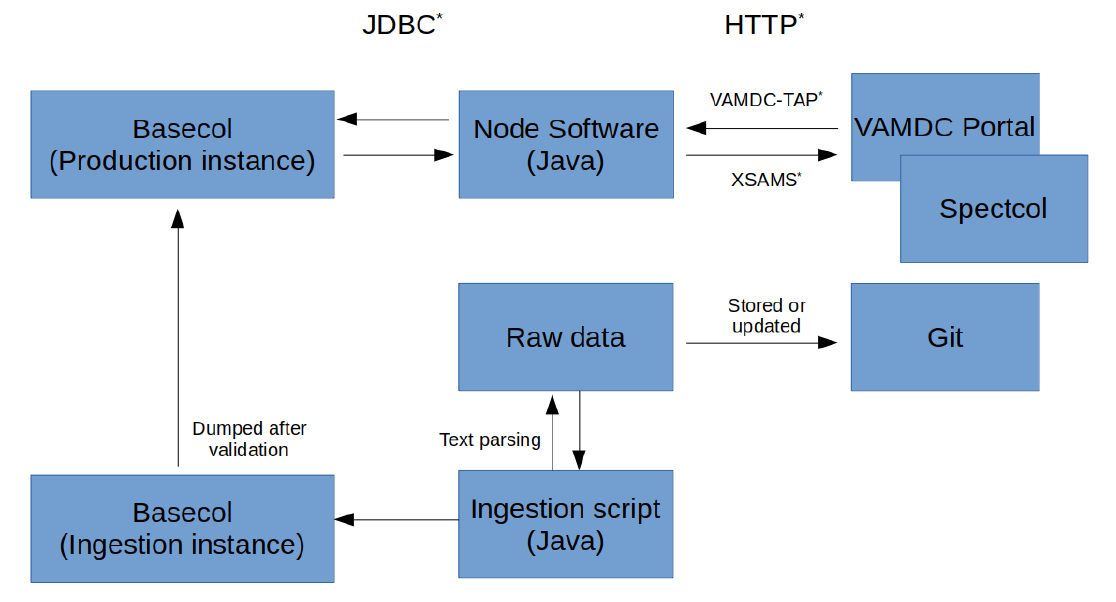
Figure 1. New structure of the BASECOL system. The term labeled with an asterisk is found in the Abbreviation